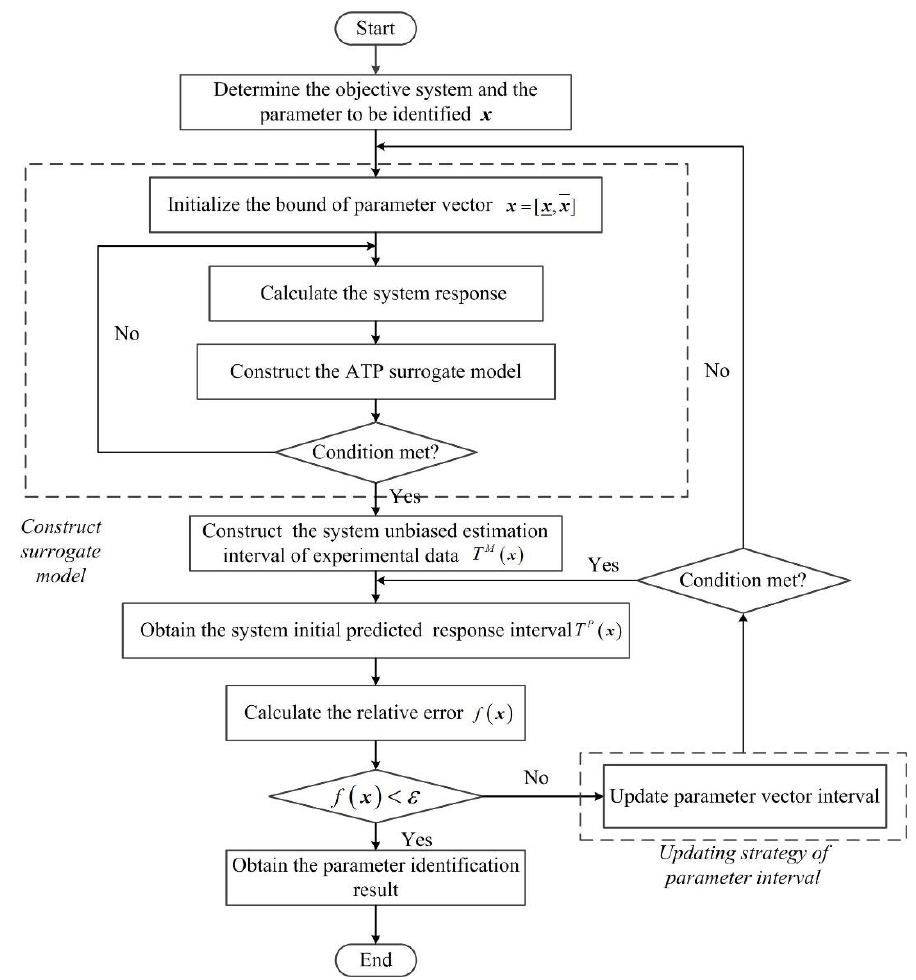
Figure 6. Flowchart of the system interval parameter identification.